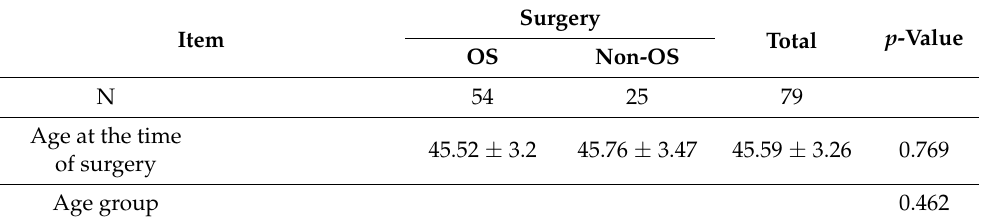
Figure 1. Flow chart of study design. OS: opportunistic salpingectomy; HT: hormone therapy. Table 1. Patient demographics between both